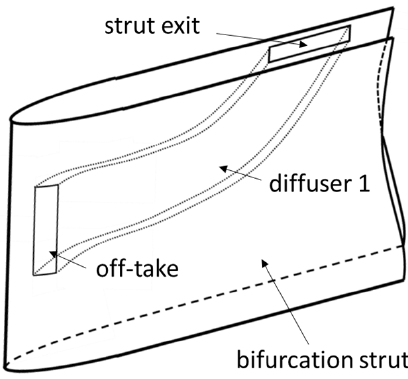
Figure 2. Bifurcation off-take concept–sketch. Depending on the position of the aerodynamic off-take on the bifurcation strut, the type of flow ingestion can vary between a total off-take and a flush off-take as shown in Figure